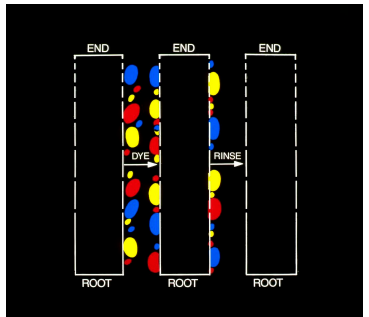
Figure 11. Visualization of interaction of temporary dyes with hair.